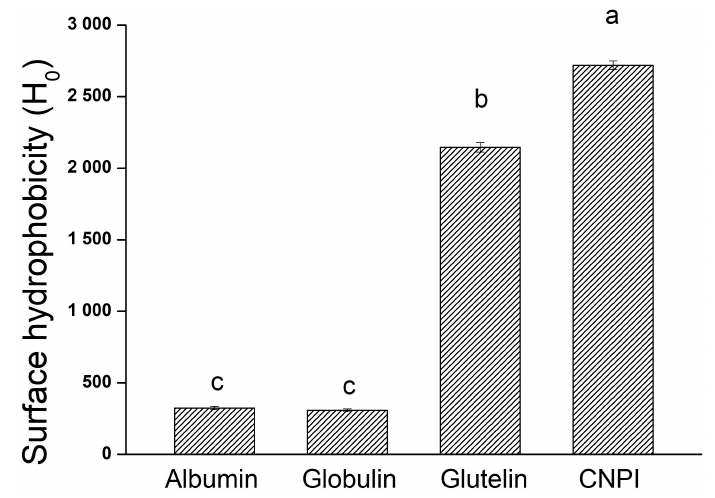
Figure 2. Surface hydrophobicity of albumin, globulin, glutelin and CNPI from cashew nut. Columns with different letters ( a – c ) are significantly different ( p < 0.05), as analyzed by the SPSS software.